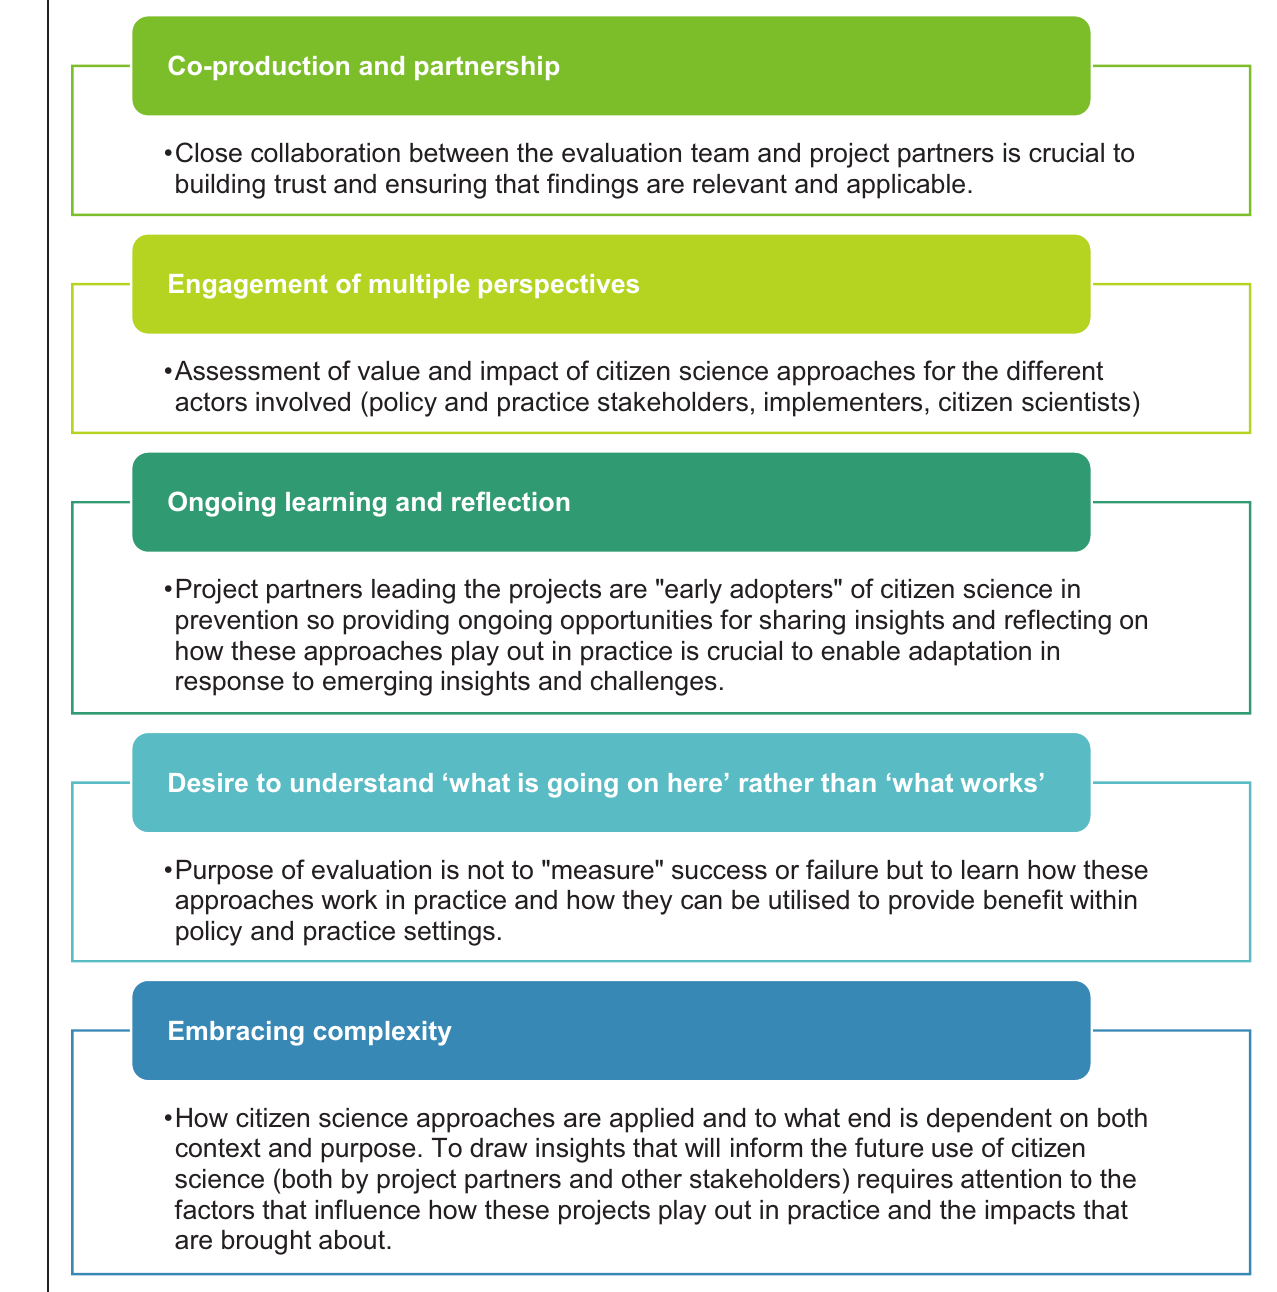
Figure 2 Principles underlying our approach to